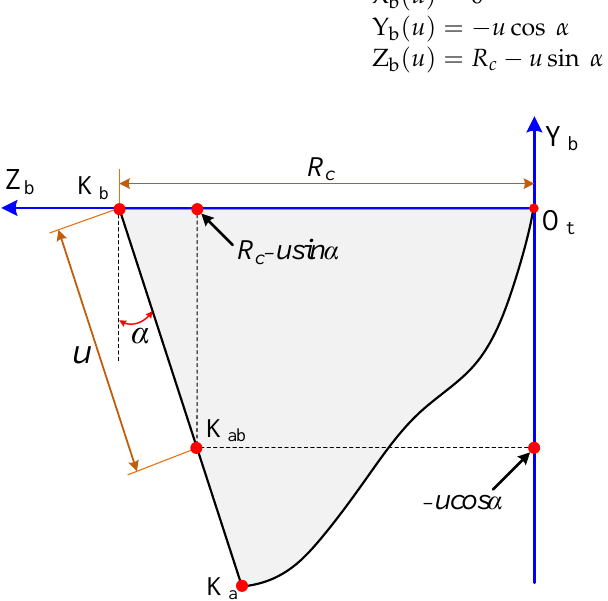
Figure 14. The detailed expression of line K b K a in Y b Z b rectangular coordinates.